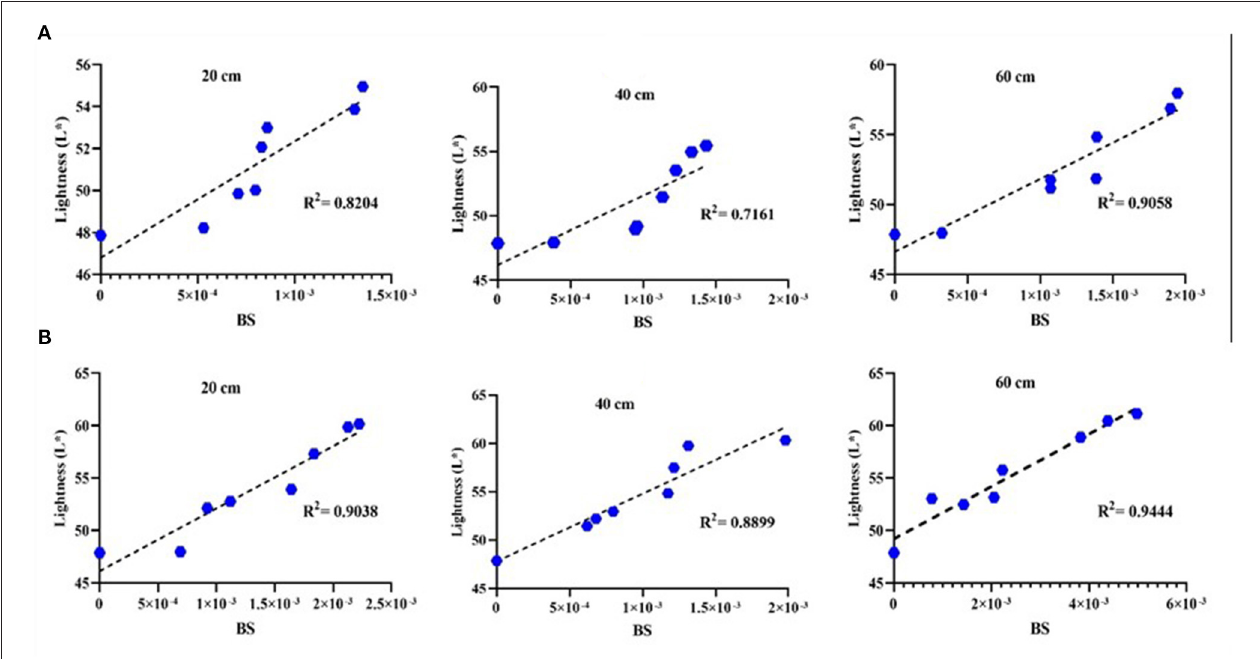
FIGURE 5 | Single linear regression between BS and L* at different drop heights (20, 40, and 60cm) during 14 days at (A) 10 ◦ C and (B) 22 ◦ C storage conditions.